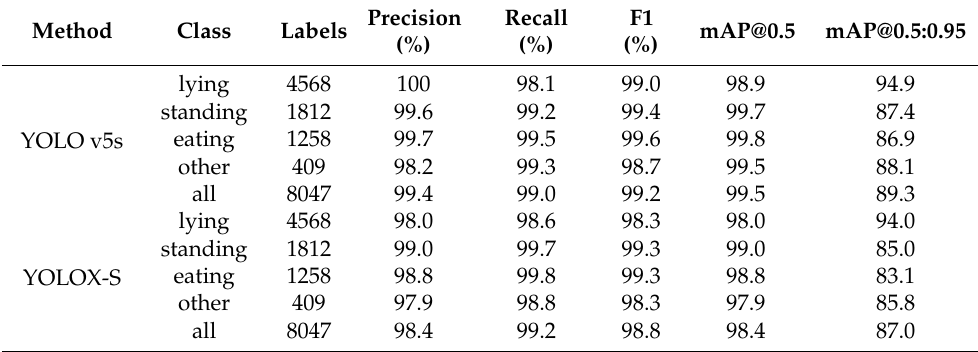
Table 2. Experimental results of YOLOX-S and YOLO v5s